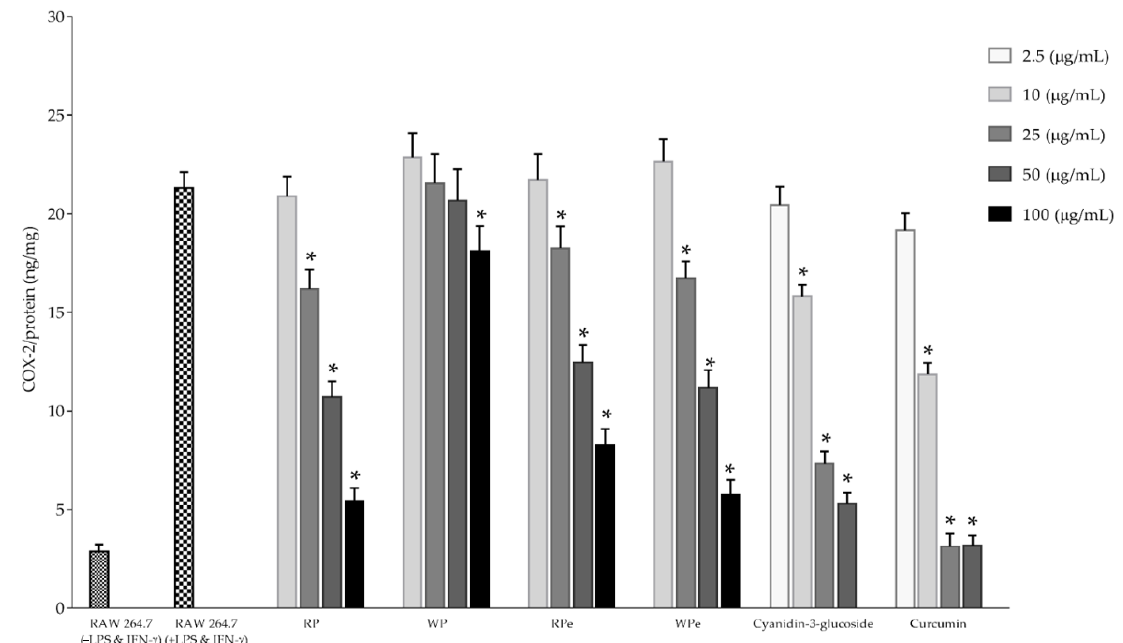
Figure 4. The inhibition effect on iNOS production in LPS/IFN-γ-induced RAW 264.7 cells of selected anthocyanin extracts (RP, WP, RPe, and WPe). * Significant differences at the 95% confidence interval compared to control RAW 264.7 cells treated with LPS and IFN-γ.